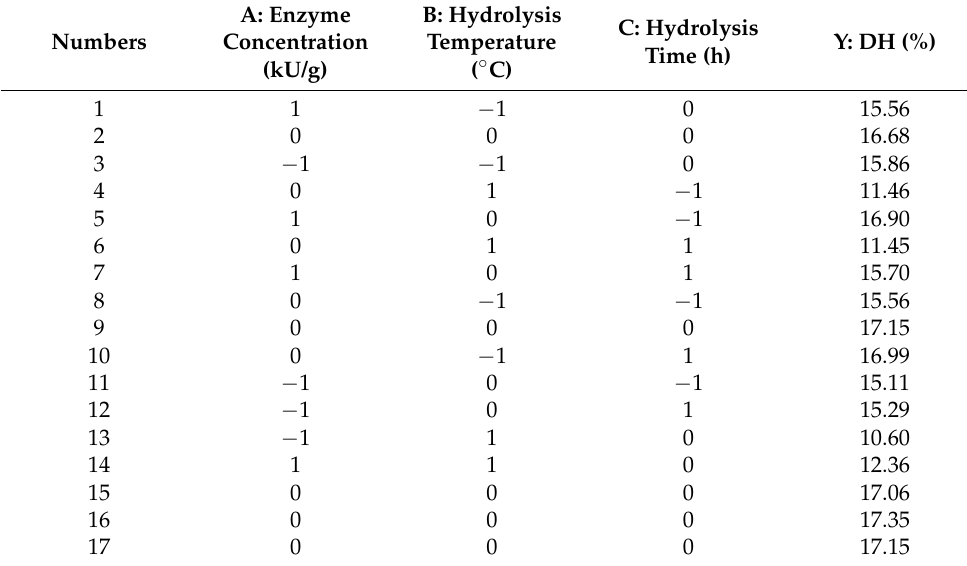
Table 3. Design proposal and experiment results of response surface.